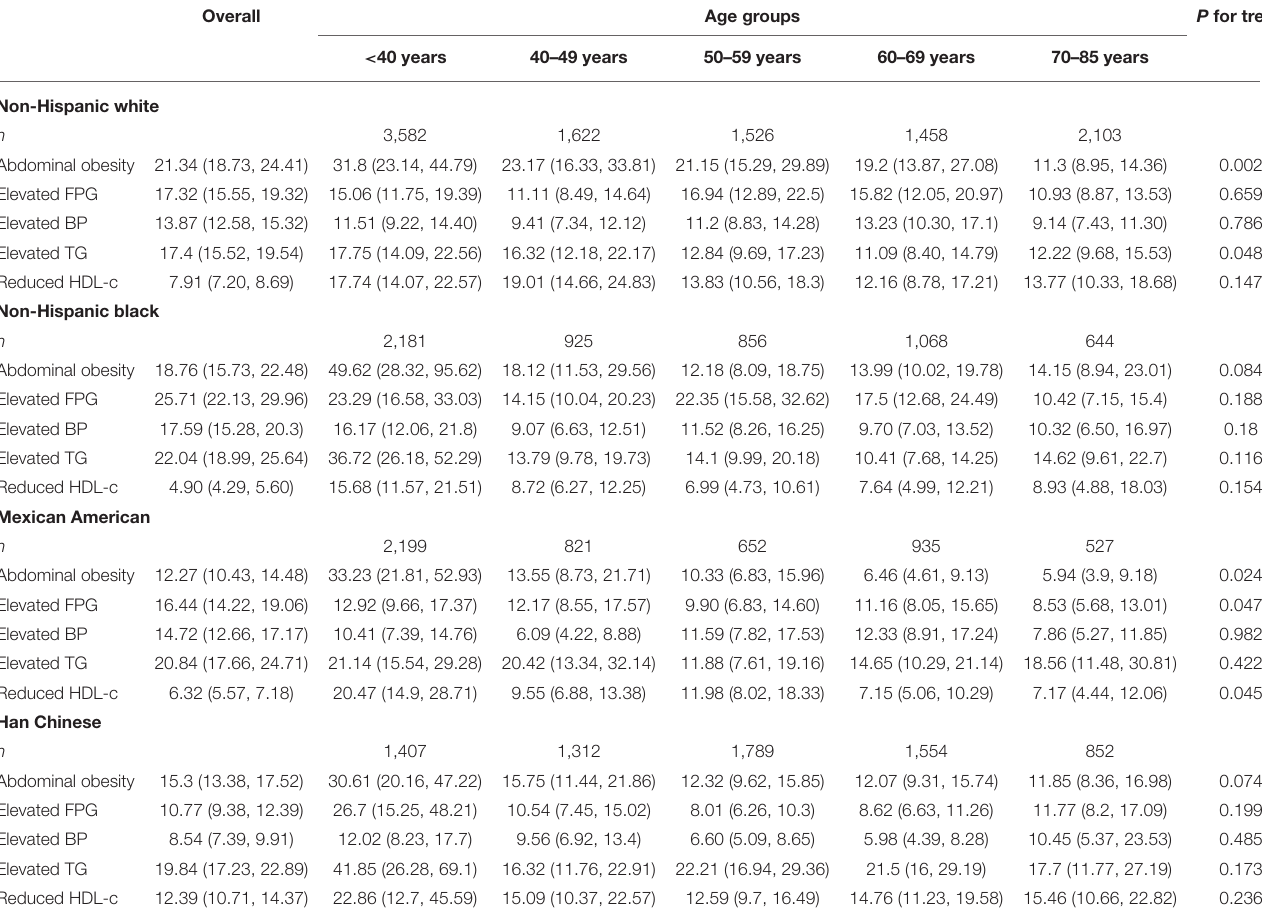
TABLE 2 | Odds ratios (95% confidence intervals) for the associations between MetS and its components. Overall Age groups P for